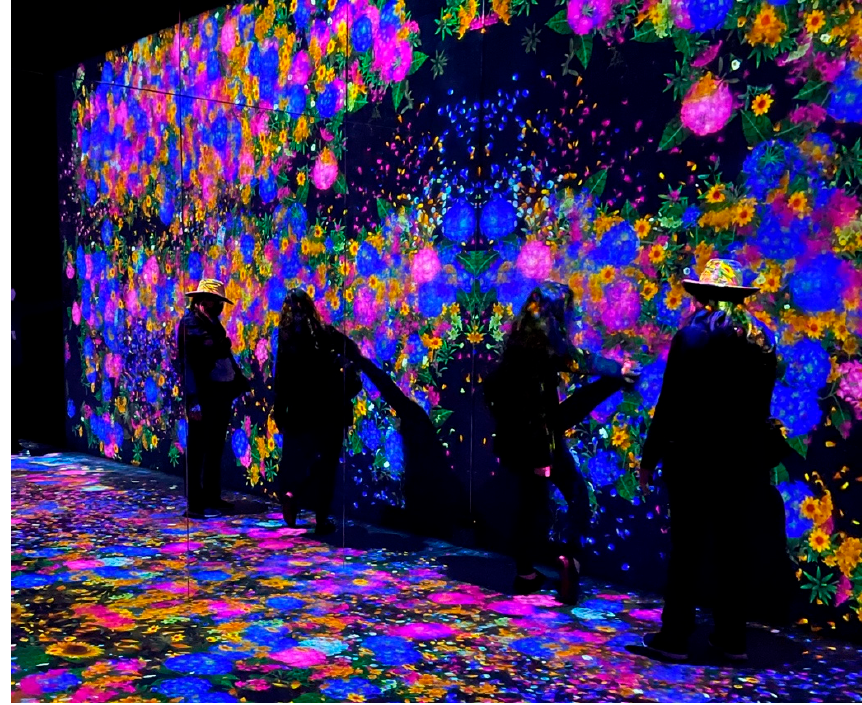
Figure 6. teamLab, Forest of Flowers and People: Lost, Immersed and Reborn (Autumn), 2017/2021, Asian Art Museum of San Francisco; photograph by the author, 2022.